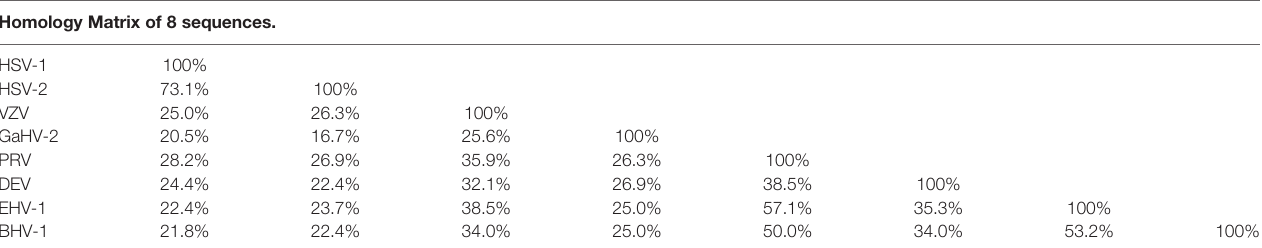
TABLE 1 | Comparison of protein sequence similarity of ICP22 homologous protein of a -HV. Homology Matrix of 8 sequences.